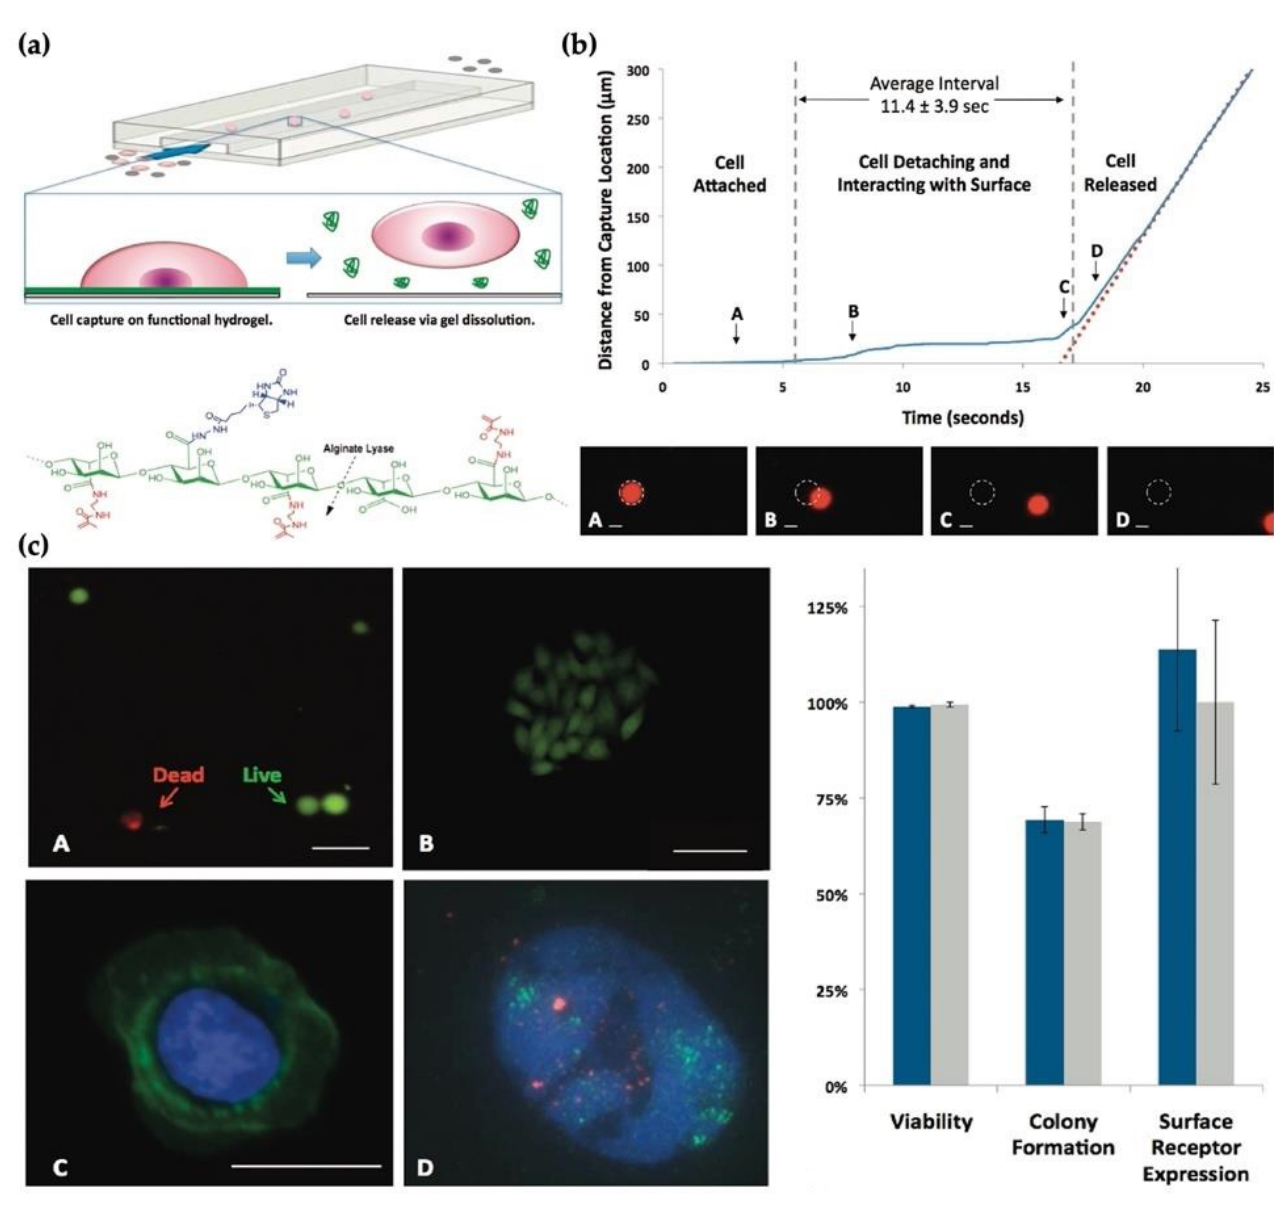
Figure 1. ( a ) Sacrificial hydrogel coatings microfluidic devices; ( b ) The gentle nature of the release process as the cell starts; ( c ) released cells for ( A ) viability using a fluorescent LIVE (green)/DEAD (red) assay and ( B ) colony formation, ( C ) immunostaining of cell surface receptors, ( D ) FISH (fluorescence in situ hybridization) analysis in a released HER2 (green probe) amplified breast cancer cell; the control probe (red) [78].